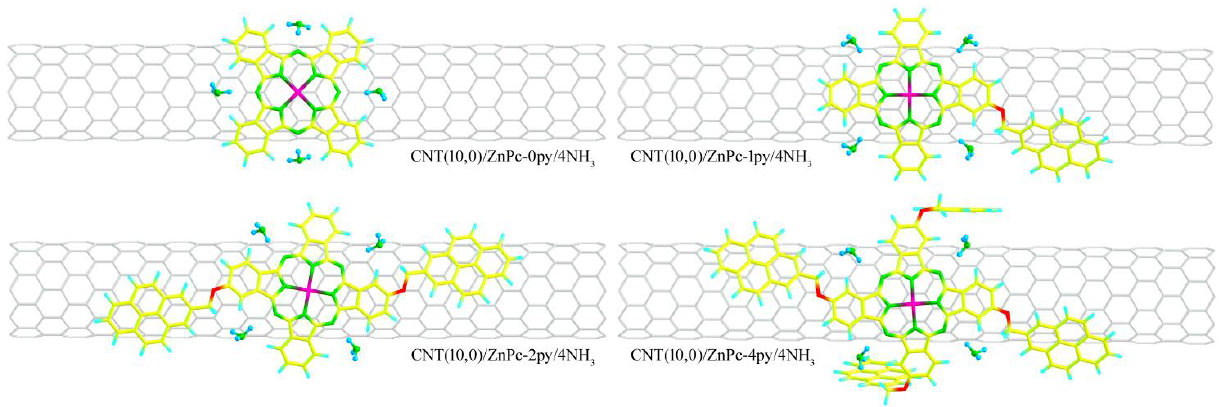
Figure 1. Geometrical structures of CNT(10,0)/ZnPc- x py/4NH 3 obtained as a result of quantum-chemical modeling by the SCC-DFTB method.